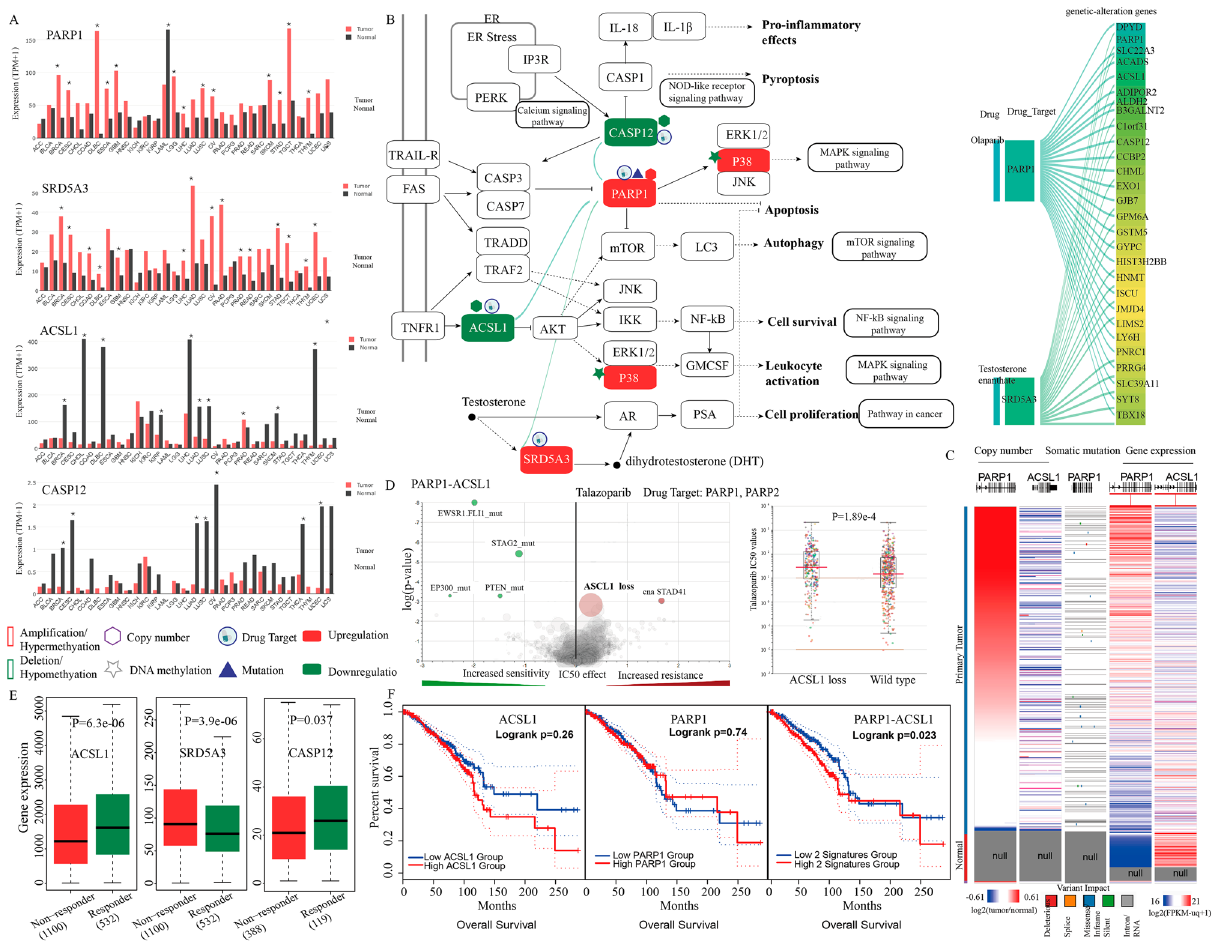
Figure 5. PARP1-associated functional regulations could be potential targets for combination therapy and prognostic markers of breast cancer. ( A ) The gene expression profile across all tumor samples and paired normal tissues. Each dot represents the expression of each sample. Asterisks represent FDR < 0.05. ( B ) PARP1-associated functional regulations (green line) affect multiple important biological pathways 81 . ( C ) Genetic alteration and gene expression alteration of genes using UCSC Xena. ( D ) Association between genetic alteration of genes and drug sensitivity of PARP1 inhibitor analyzed using ANOVA based on GDSC. The size of each point